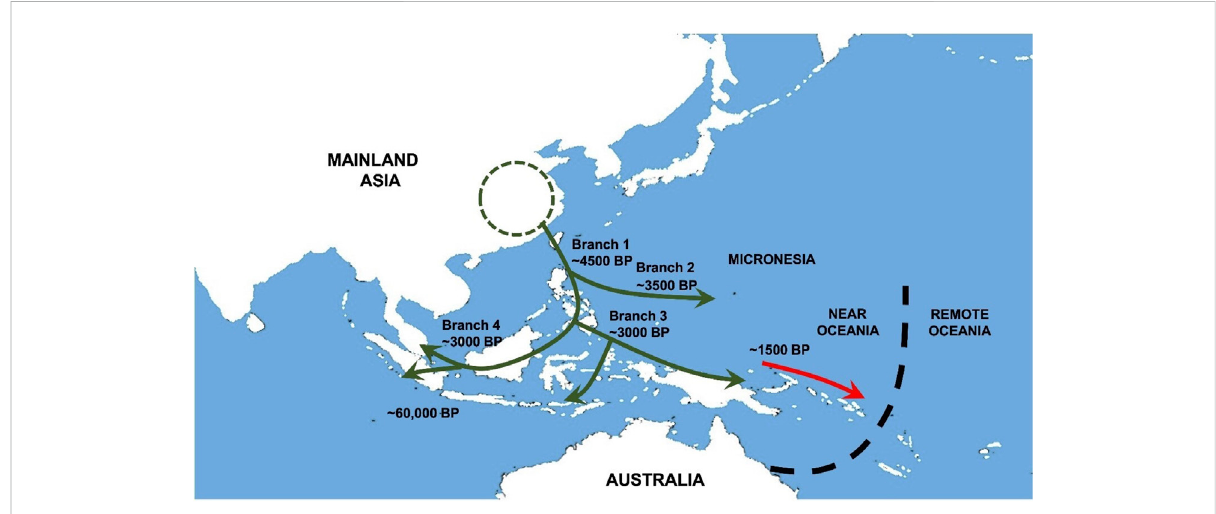
FIGURE 1 Austronesian population movements in Southeast Asia and Oceania. Early movements of Austronesians (green arrow) into the Southeast Asia regionreachPhilippines,Borneo,IndonesiaandNearOceaniaapproximately4500to1500 BP.AdmixturebetweenAustronesiansandPapuansgave rise to Proto-Polynesians in northern coastal Papua New Guinea before their descendants (red arrow) migrated further out to Remote